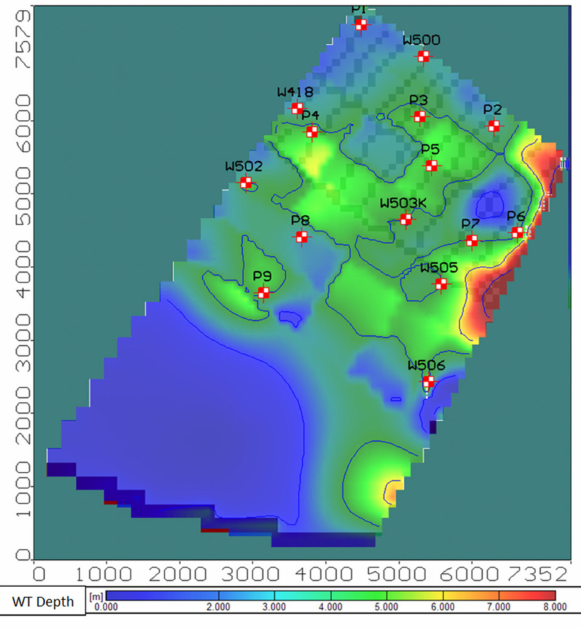
Figure 10. Groundwater depth, 15 July